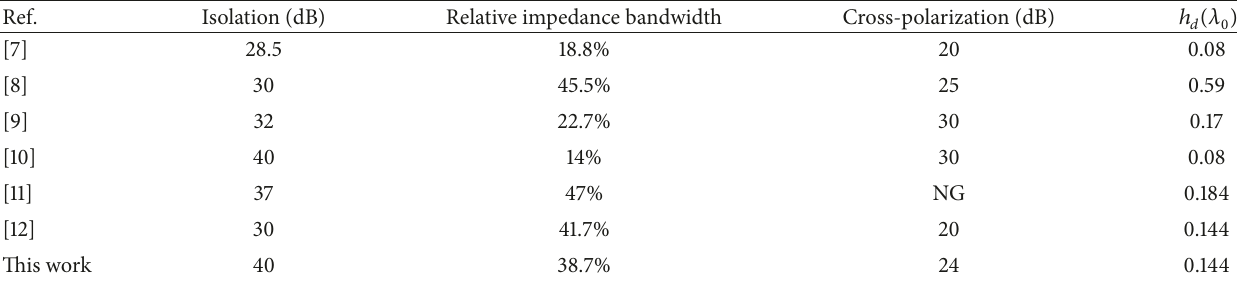
Table 1: Comparison with previous works.